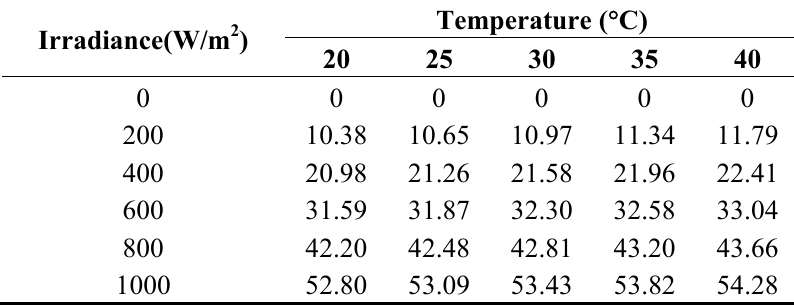
Table 4. Control gains for mass flow rate of refrigerant (unit: g).